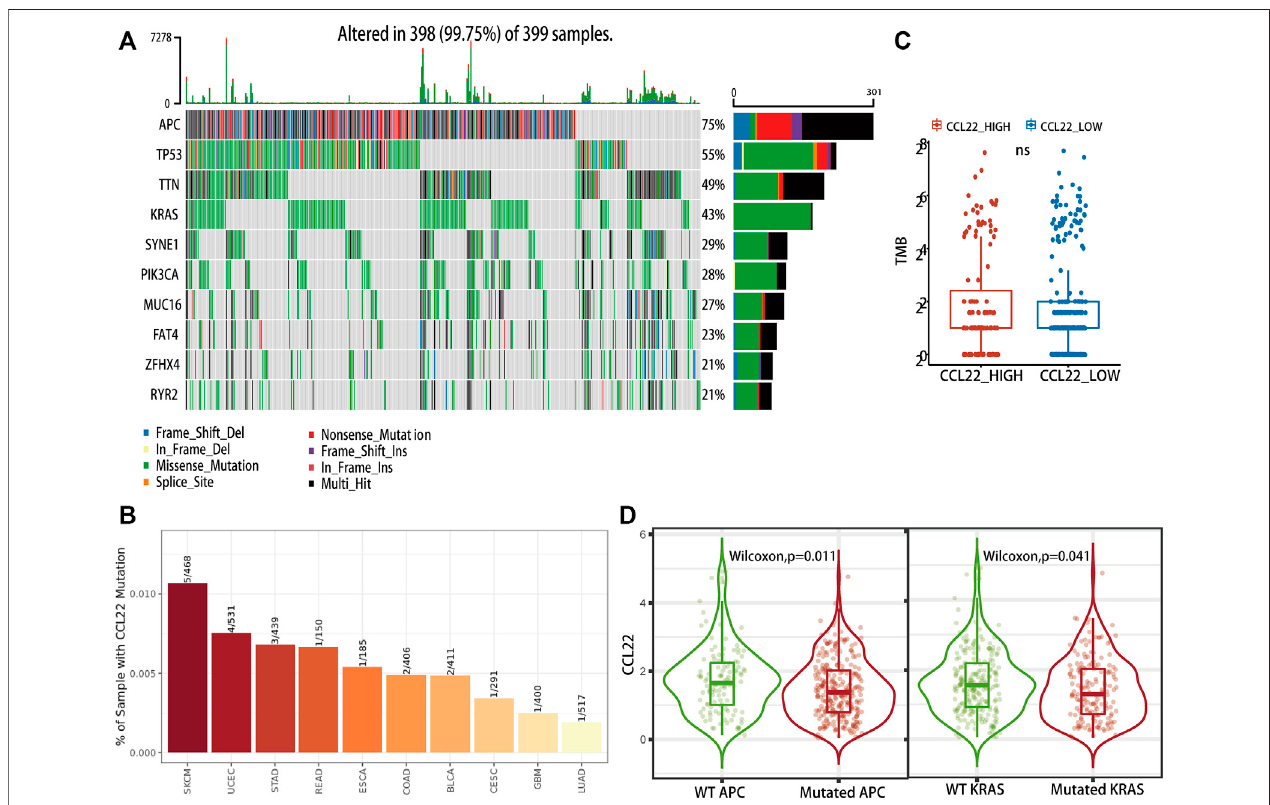
FIGURE 7 | Mutation landscape related to CCL22 in The Cancer Genome Atlas (TCGA) colon adenocarcinoma (COAD). (A) Oncoplot showing the top 10 mutational genes in TCGA COAD). (B) Mutation status of CCL22 in different cancer types. (C) Relationship between CCL22 expression and tumor mutation burden in TCGA COAD. (D) Violin plots showing the CCL22 expression in mutant and wild groups of APC and